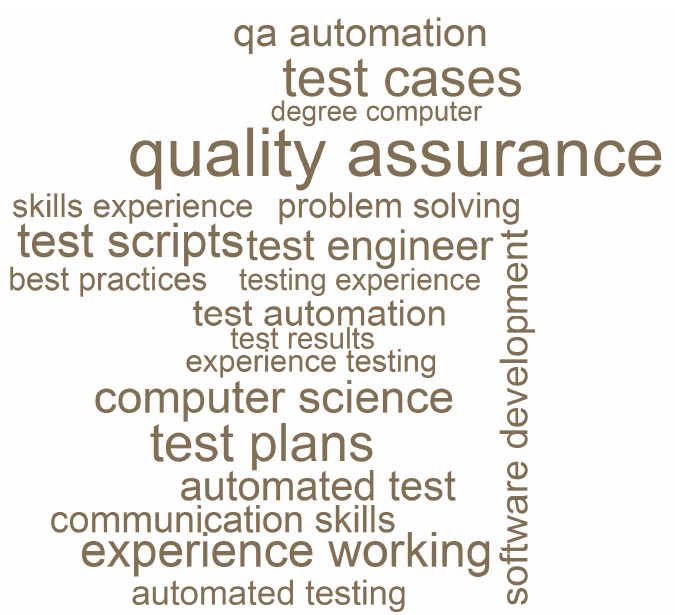
Figure 19. Job Descriptions Visualization—Test (unseen